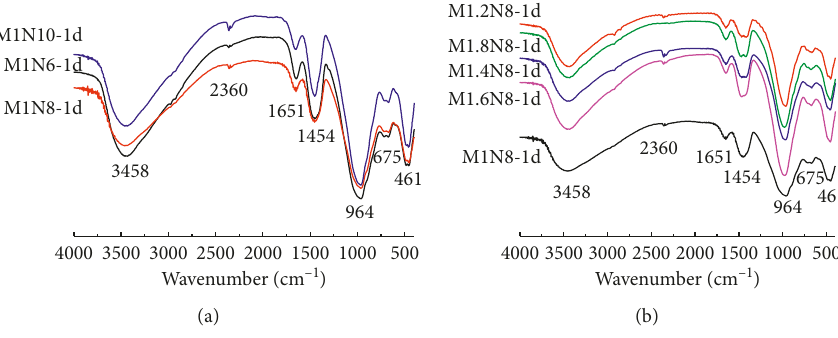
Figure 7: FTIR spectra of AAS pastes: (a) Na